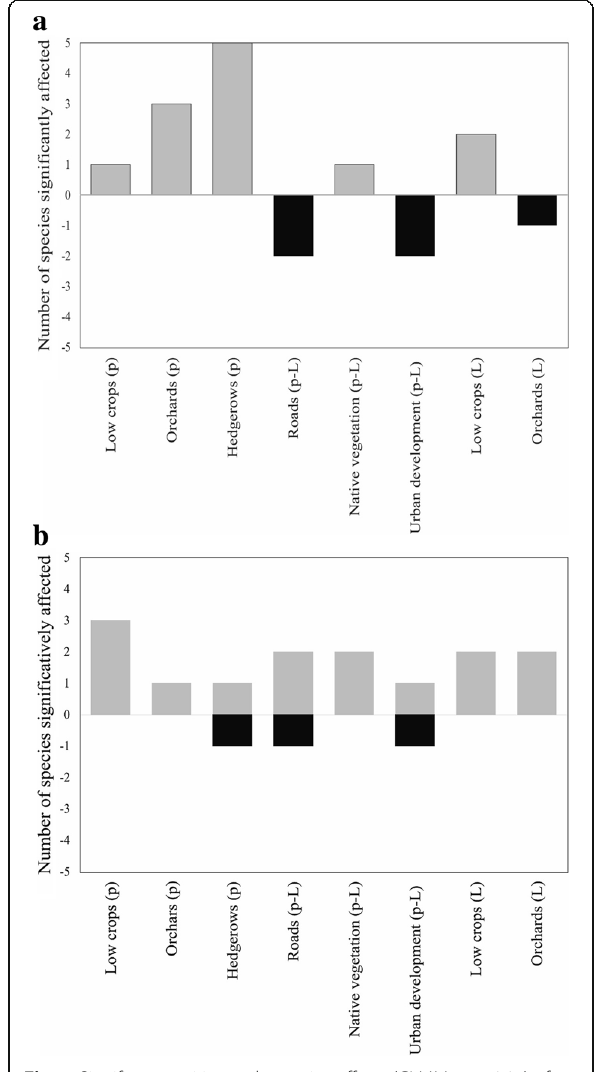
Fig. 5 Significant positive and negative effects (GLMMs, p <0.05) of land covers affecting birds at different scales in a winter and b spring